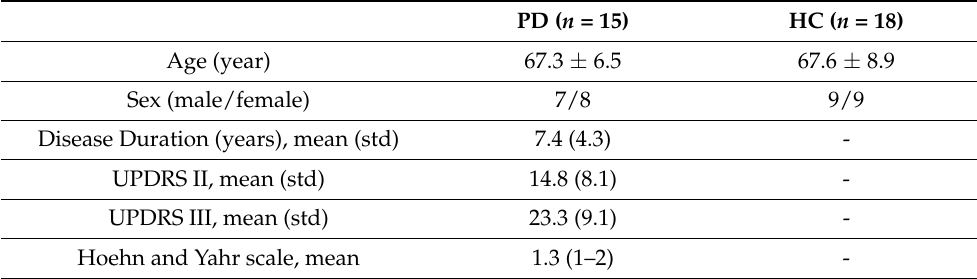
Table 1. Demographic and clinical characteristics of the study.